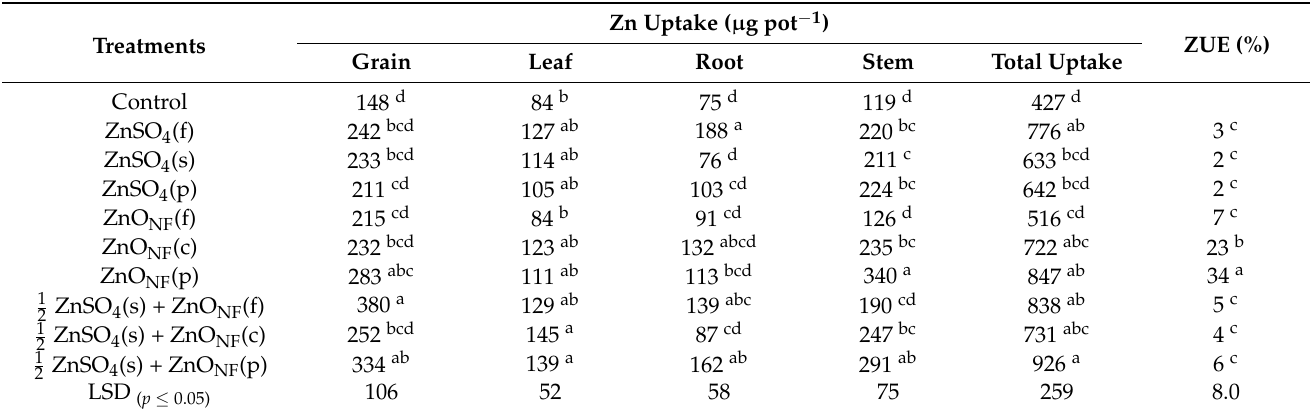
Table 4. Zn content in different parts of the crop and total Zn uptake as affected by different modes and sources of Zn